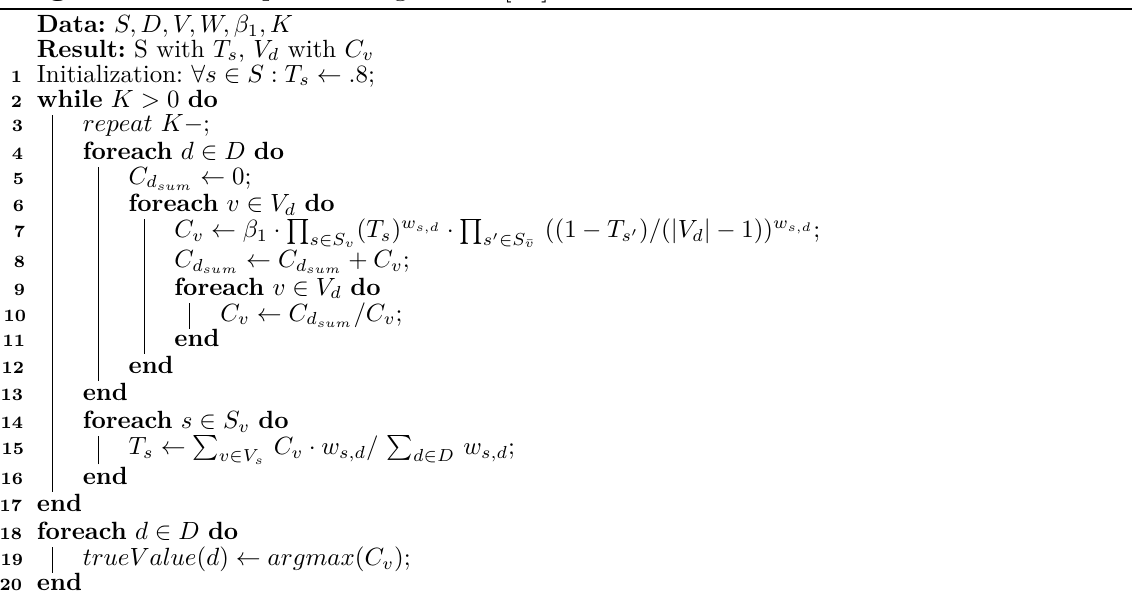
Algorithm 1: SimpleLCA algorithm